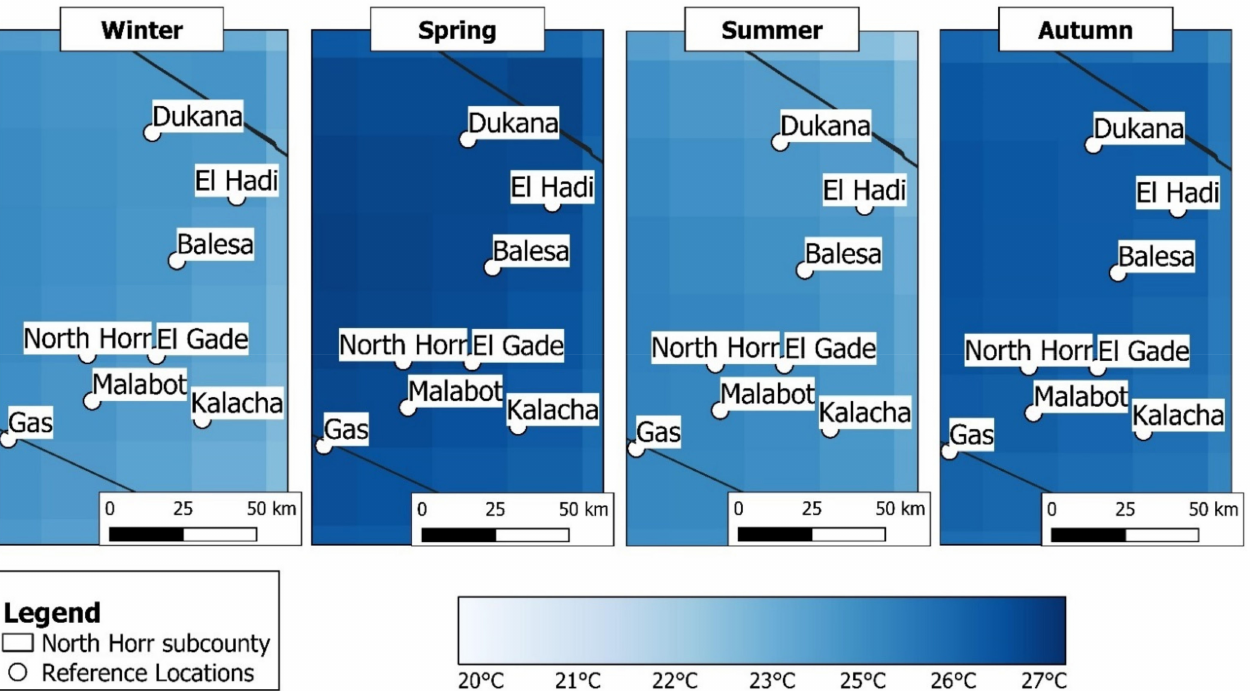
Figure 9. ORH isotherm maps representing seasonal mean T MIN values at the local scale for North Horr Sub-County, for winter (January, February, March), spring (April, May, June), summer (July, August, September) and autumn (October, November, December) seasons. White dots represent the location of the reference